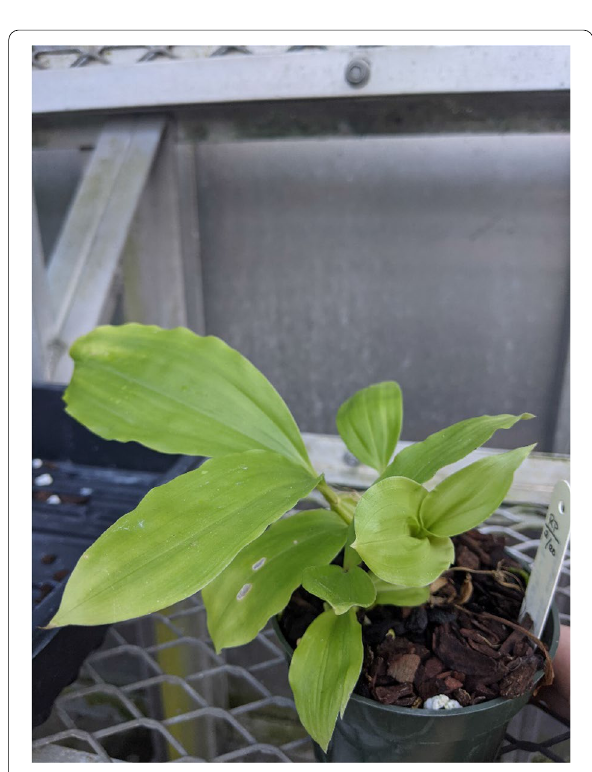
Fig. 6 Greenhouse established seedling of the South American native, Gongora grossa , that was cultivated at the Missouri Botanical Garden in vitro using Tulasnella calospora 266. Approximately 17% of the seeds germinated using the